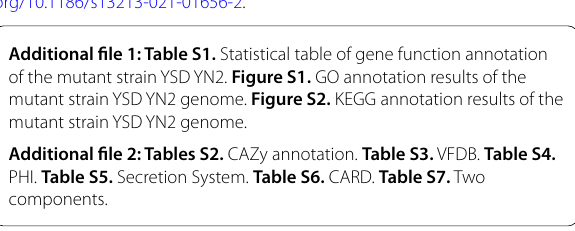
Additional file 1: Table S1. Statistical table of gene function annotation of the mutant strain YSD YN2. Figure S1. GO annotation results of the